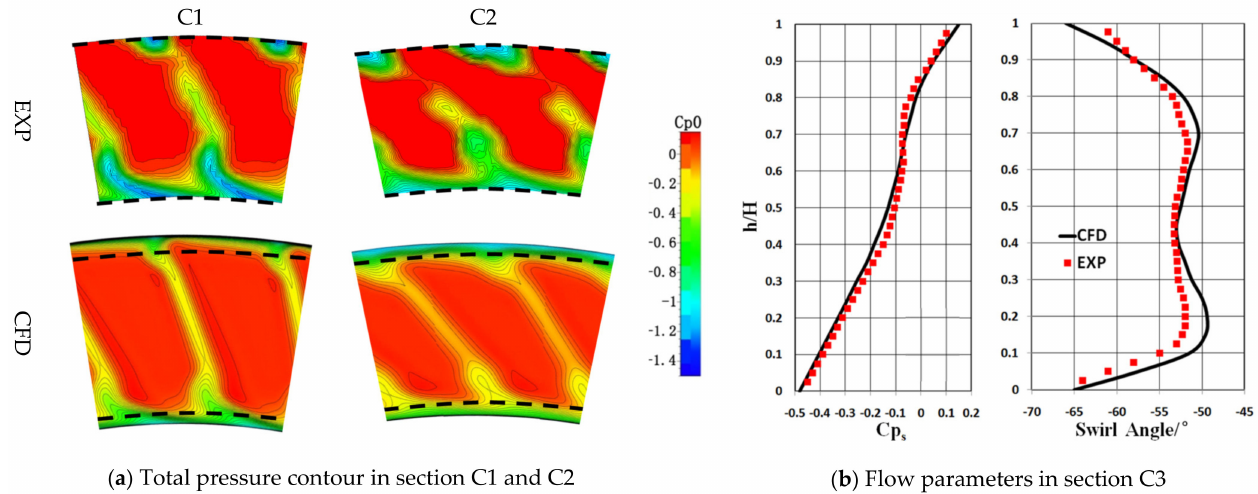
Figure 7. Comparison between experimental and numerical